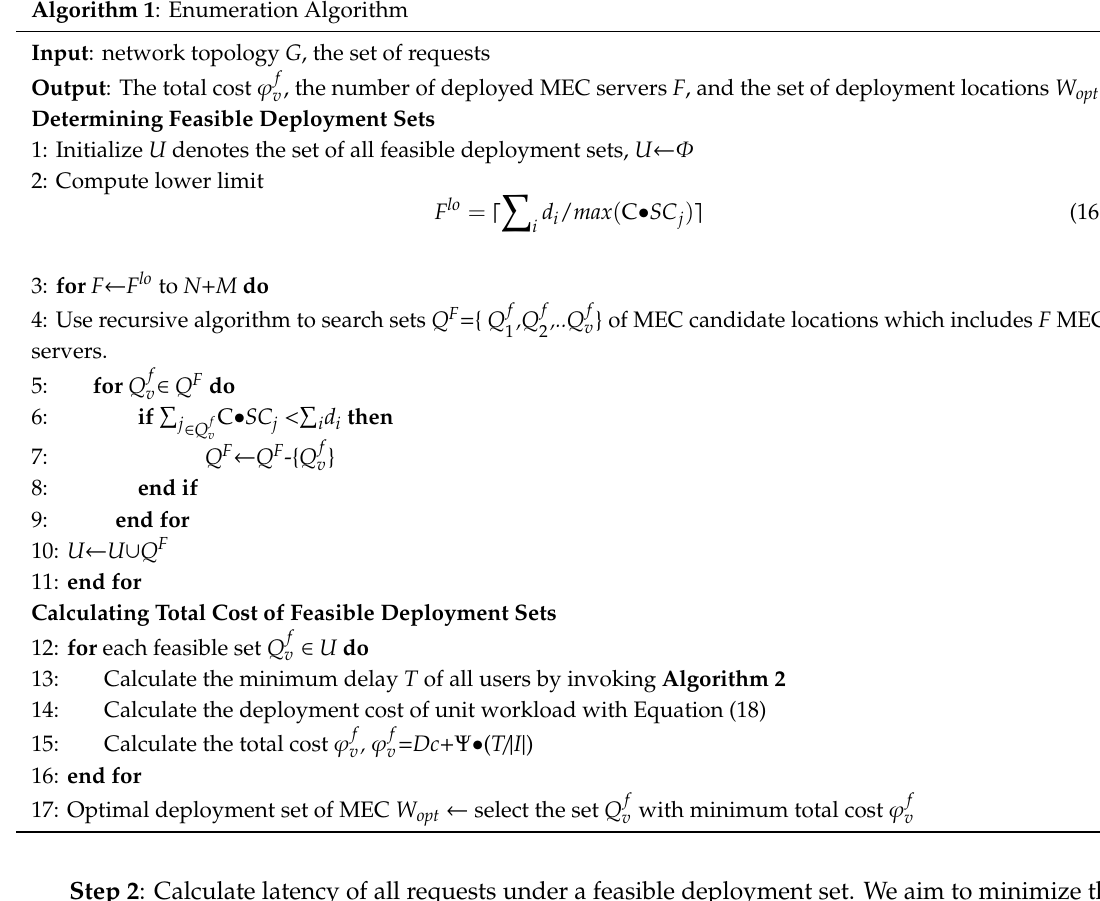
Algorithm 1 : Enumeration Algorithm